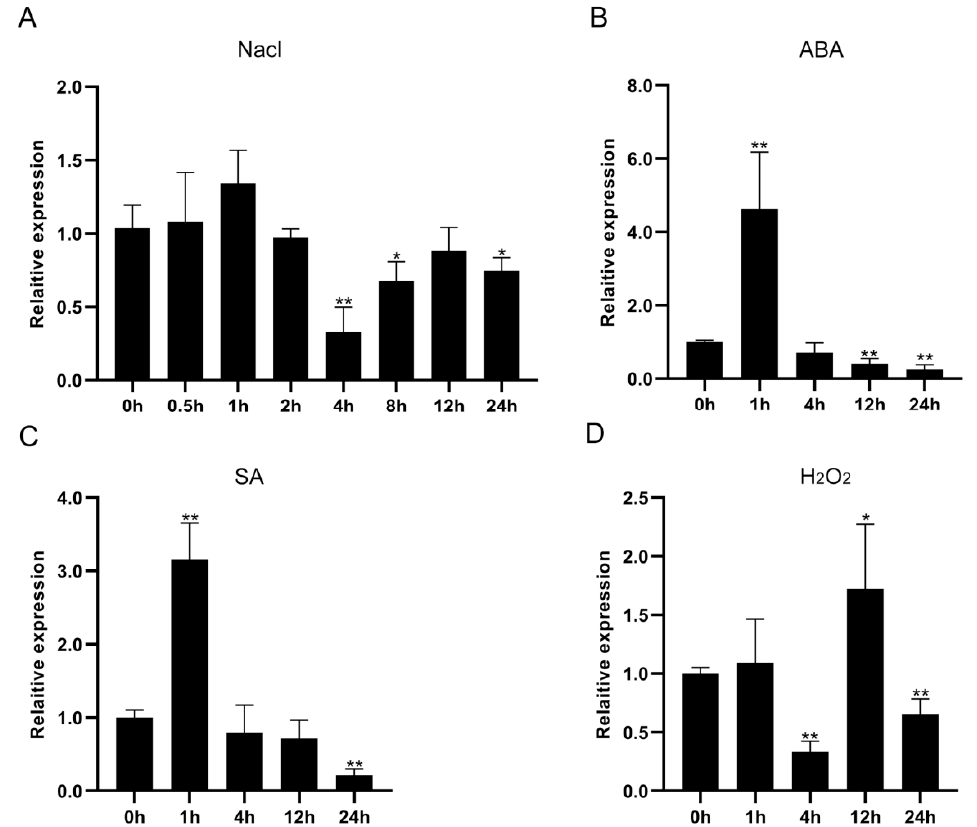
Figure 2. Expression levels of CbWRKY27 under diverse stress treatments. Total RNA extracted from whole plants exposed to ( A ) 300 mM NaCl, ( B ) 100 µ M abscisic acid (ABA), ( C ) 5 µ M salicylic acid (SA), and ( D ) 100 µ M H 2 O 2 were used for Quantitative real-time PCR (qPCR). The data represent the means ± SD (n = 3), * p < 0.05 and ** p < 0.01 using Student’s t -test. The six-week-old seedlings were subjected to the treatment.